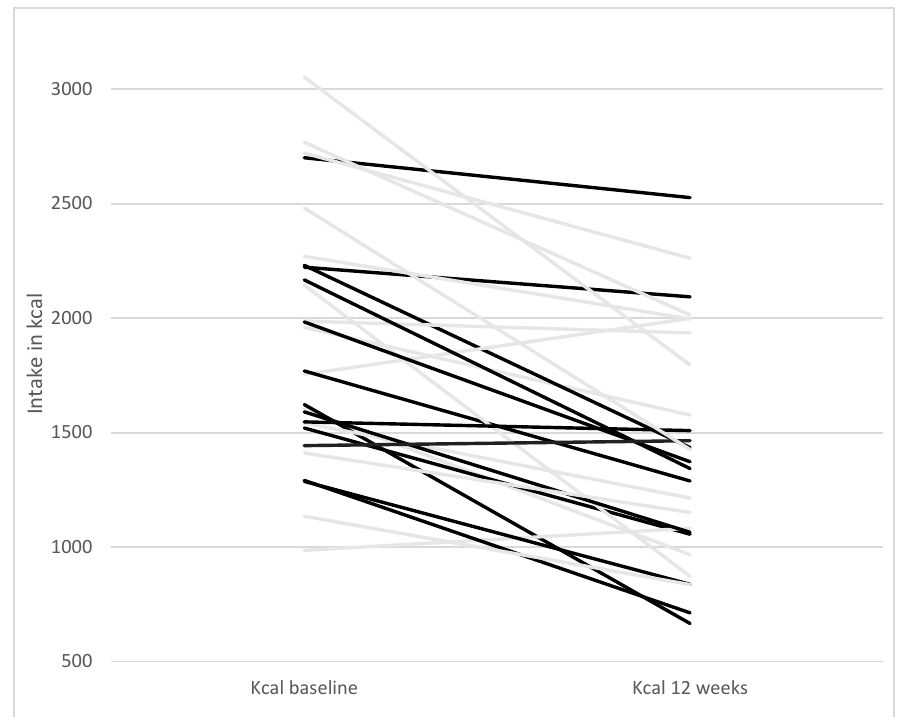
Figure 1. Paleo ratio with one line per participant starting with the Paleo ratio at baseline and end- ing at Paleo ratio at 12 weeks. Grey lines represent participants of the Paleolithic diet only group and black lines participants of the Paleolithic diet and exercise group.